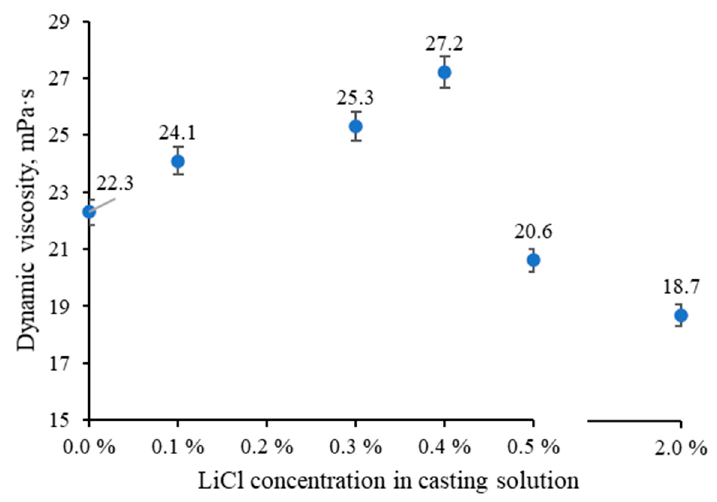
Figure 2. Dynamic viscosity values were measured with the falling sphere method at 23 °C.